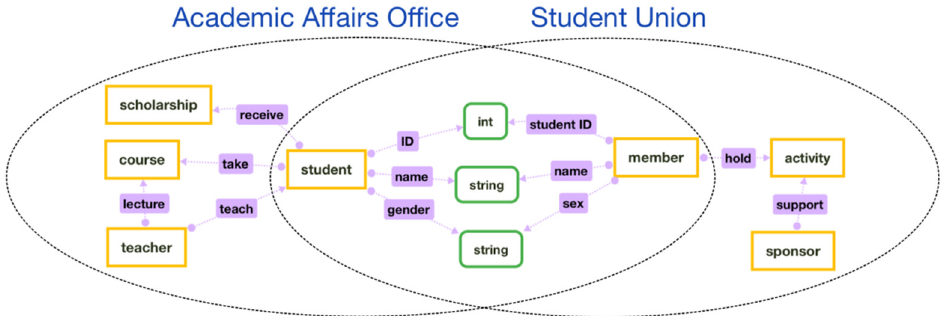
Figure 1. Equivalent entity type student and member in different schemas.